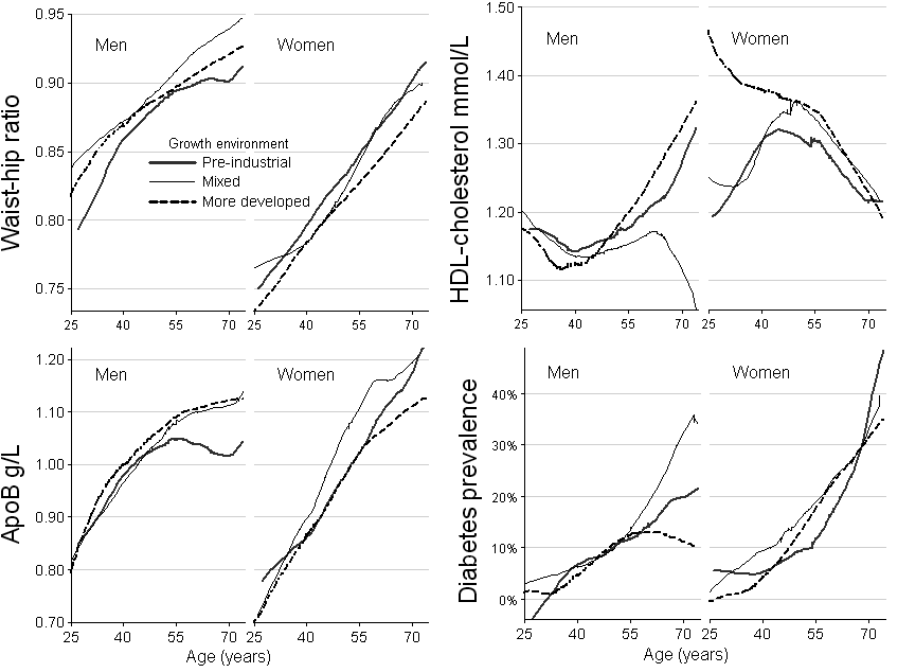
(Table 3), adjusted for age (model 1) or additionally adjusted for socio-economic status and lifestyle (model 2). In contrast, waist-hip ratio was lower and HDL-cholesterol was higher in women who had grown up in Hong Kong than in women who had grown up in Guangdong, adjusted for age (model 1) or additionally adjusted for